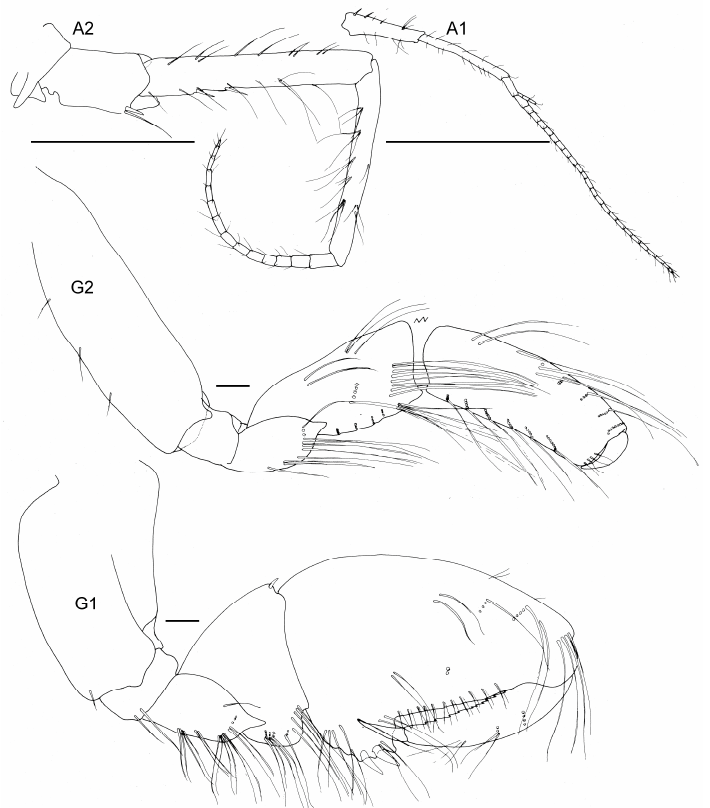
Figure 14. Unciola icelandica sp. nov. paratype female, 6 mm, ZMHK 62086, South Island, Iceland Basin, 1921 m. Scales: Antennae 1 and 2 1 mm, gnathopods 1 and 2 0.1 mm.